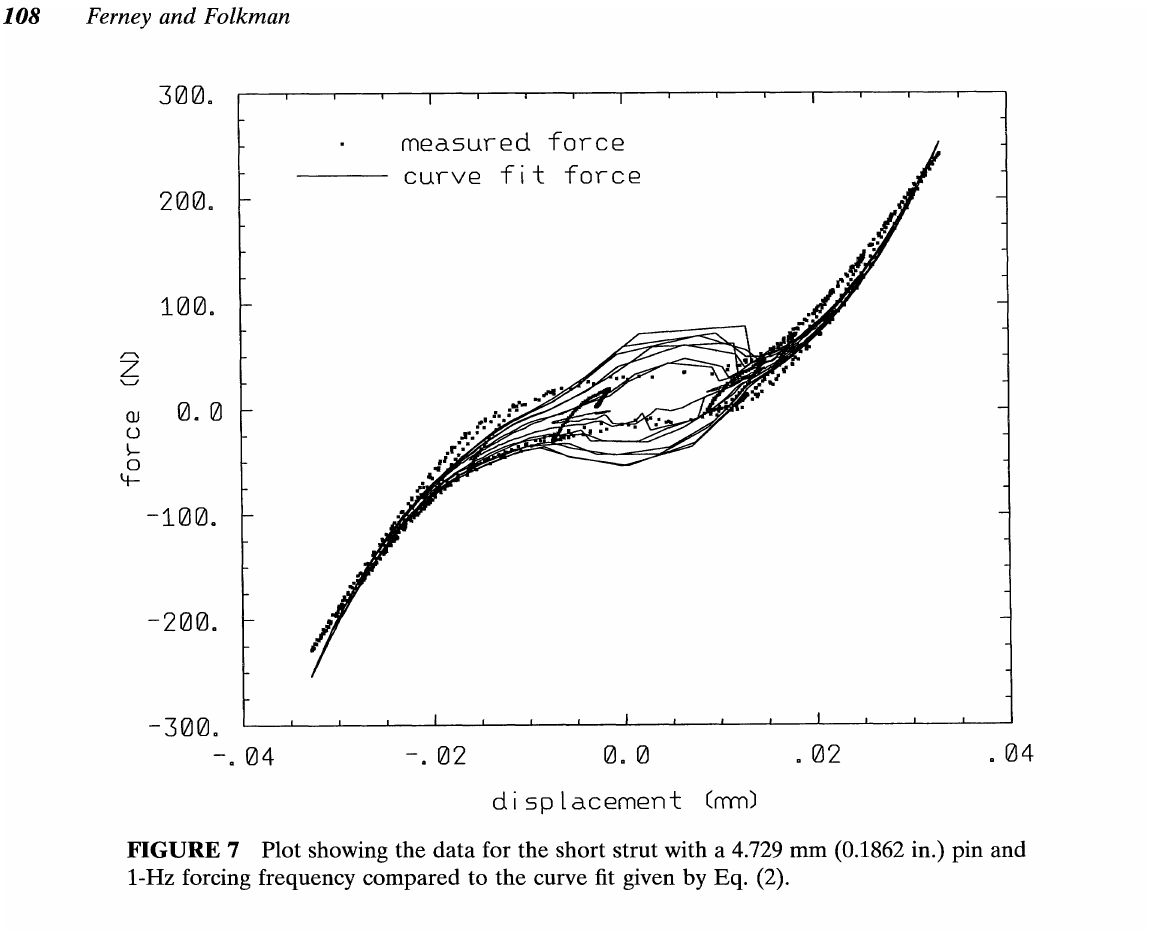
FIGURE 7 Plot showing the data for the short strut with a 4.729 mm (0.1862 in.) pin and I-Hz forcing frequency compared to the curve fit given by Eq.